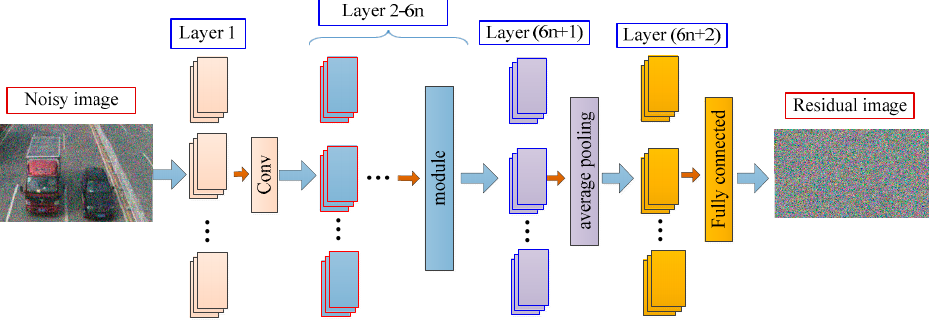
Figure 2. The architecture of the model for aerial-image denoising; 𝑛 is the number of learning modules (the size of 𝑛 is discussed in Section 4.2.3), and the module is a multi-scale residual learning module (see Figure 4).